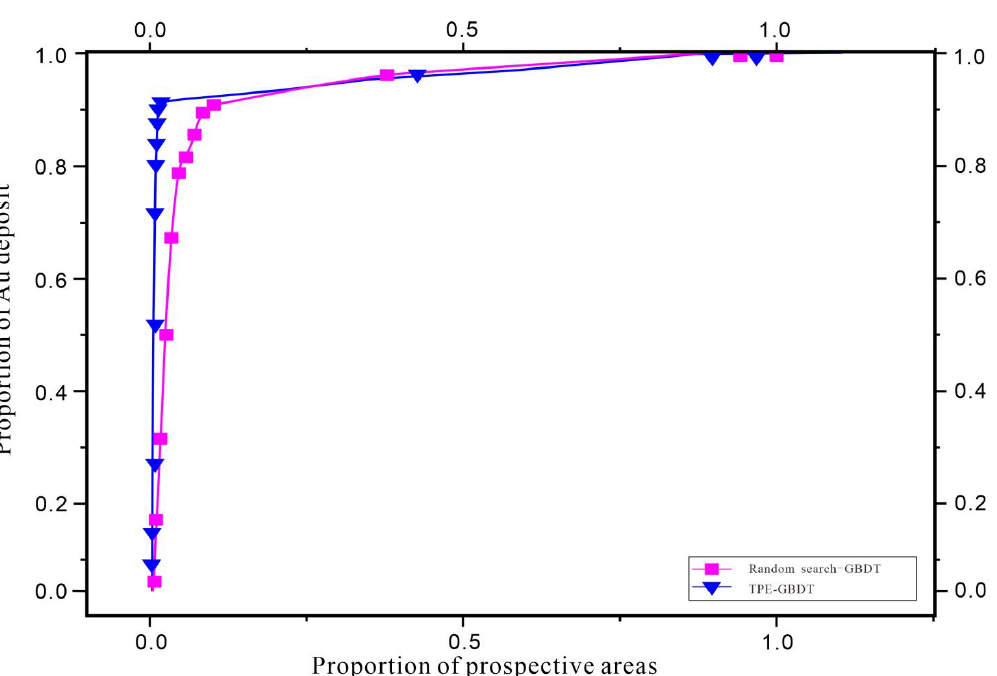
Figure 12. Performance of the Random search-GBDT and TPE-GBDT models of mineral prospectivity measured by success rate curve. Then combined with the fact that the high probability part of the Random search- GBDT and TPE-GBDT models occupy 25% of the total study area. However this 25% study area contains more than 93% of the known gold deposits (Figure 12). Finally, in order to delineate high-favorable targets in the study area. The cut-off values of Youden index in the ROC curve were adopted to discretize the TPE-GBDT and random search- GBDT predictive models, with the thresholds of 0.9211 and 0.7371, divided the prospec- tivity map of TPE-GBDT and Random search models into high potential (favorable) and low potential (non-favorable) areas, respectively. The highly favorable areas in the TPE- GBDT model (Figure 13b) captured 91% of known Au deposits within only 10.22% of the Xiong’er shan area, while the high ly favorable areas of the Random search-GBDT model (Figure 13a) contained the same percentage of known Au occurrences but within larger areas (16.84%). Results suggested that the TPE-GBDT model is more consistent with the actual geological conditions, and more suitable for the next step of the exploration work.